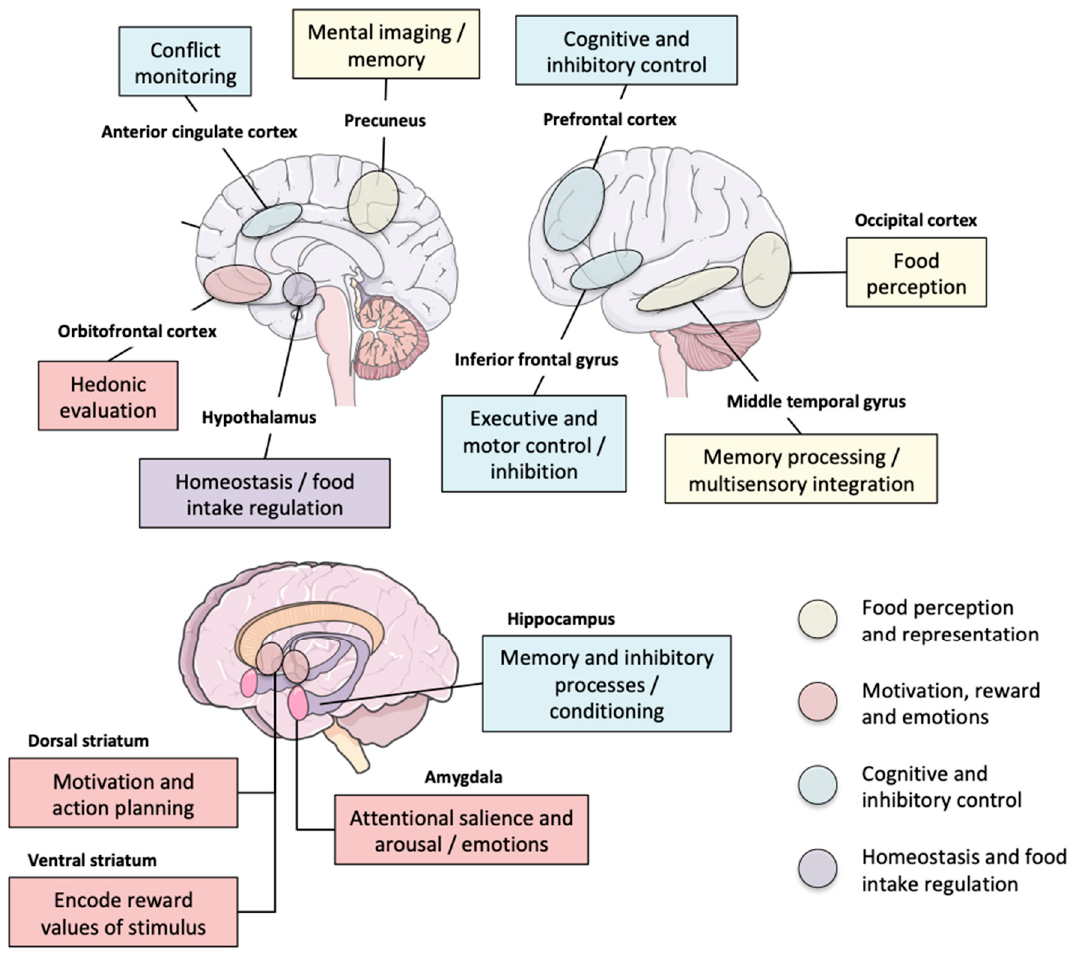
Figure 2. Neurocognitive functions and brain areas that are impacted by food addiction and for which people who meet the YFAS criteria for food addiction have different brain activity, metabolism, or functional connectivity compared to normal subjects. Please refer to Table 2 for details on results and imaging modalities used. Brain schematic representations were collected from Servier Medical Art (Suresnes, France; http://www.servier.fr).